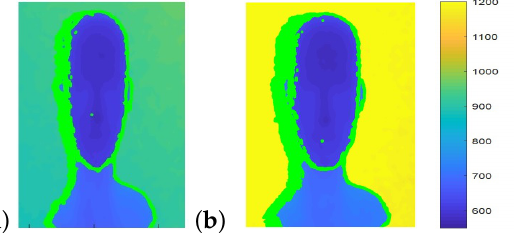
Figure 18. In both images, the object’s distance from camera is 600 mm. The distance of the back- ground from the camera is ( a ) 880 mm and ( b ) 1200 mm. Shadow pixels are marked in green on the left side of the head. The greater the distance between object and background, the wider the